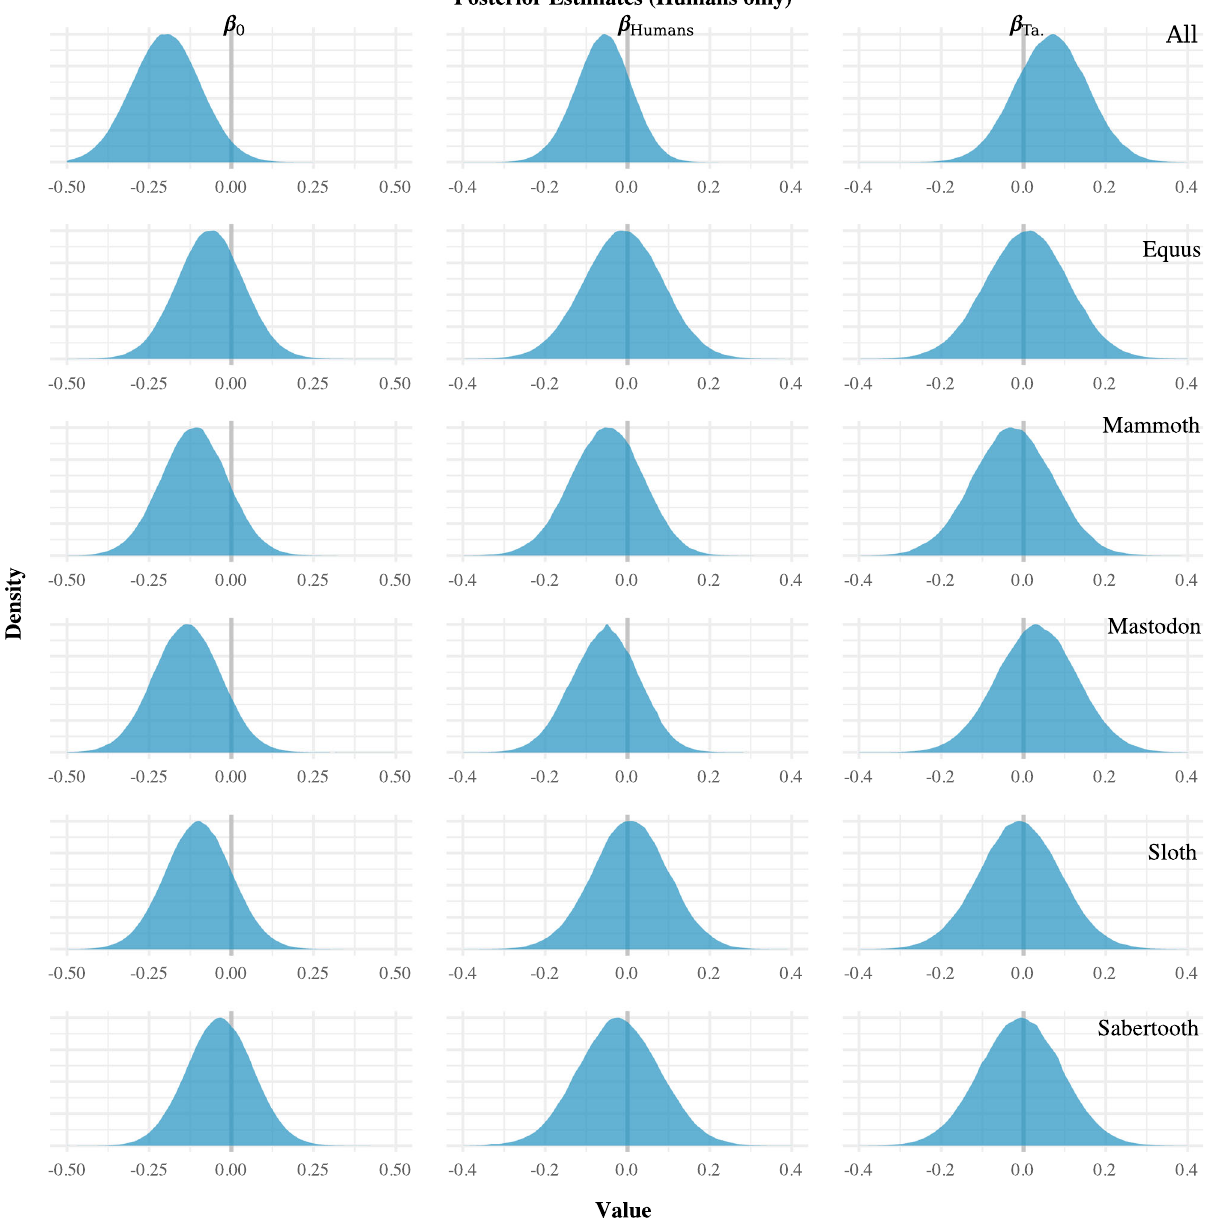
Fig. 2 Regression results for the “ humans-only ” models. The left column ( β 0 ) indicates the model intercept (the mean level of the megafauna proxy when all other covariates are held constant at zero, which, in this case, has no substantive interpretive meaning); the central column ( β Humans ) indicates the effect of human population size on megafauna population size; and the right column ( β Ta ) indicates the effect of taphonomy. If human population size was an important driver of megafauna extinction, the estimate(s) would differ (i.e., be non-overlapping) from zero (denoted by the vertical grey lines). Note that in each case, the human model ( β Human ) posterior estimates overlap zero, which indicates no relationship between the radiocarbon-date